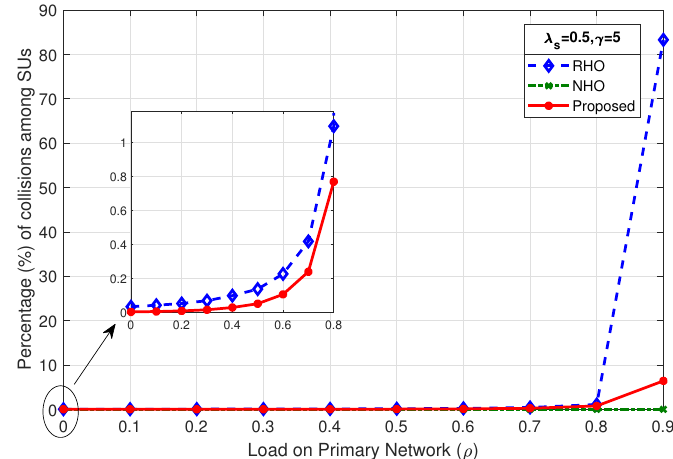
Figure 5. Comparison of percentage of collisions among SUs for λ s = 0.5, γ =